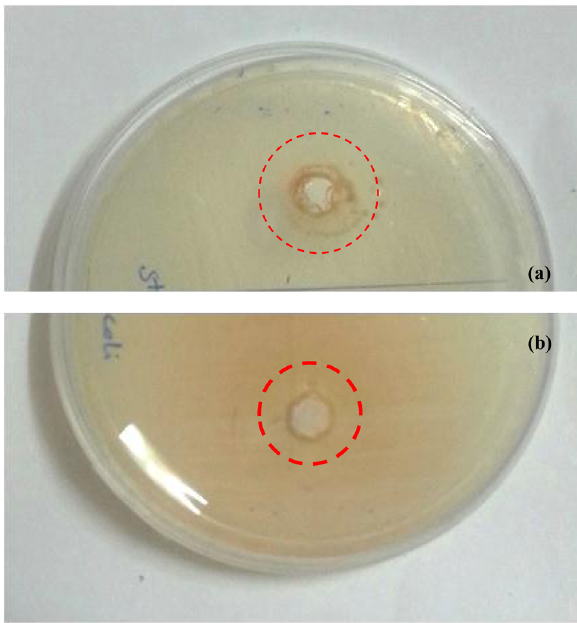
Figure 8: Created zones of inhibition within the plates inoculated with S. aureus ( a ) and E. coli ( b )